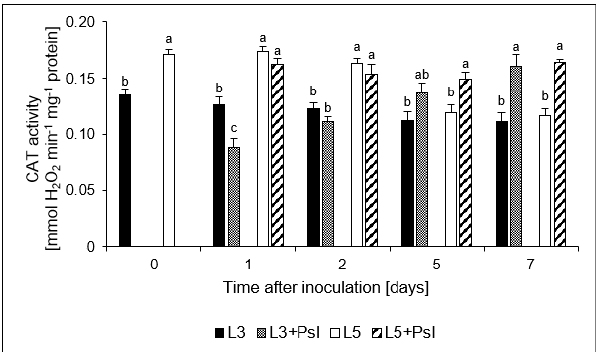
Figure 5. Catalase (CAT) activity. Values are means of four replicates (±SD). Different letters (a – b) indicate significant ( p ≤ 0.05) differences between experimental variants within a given time point.